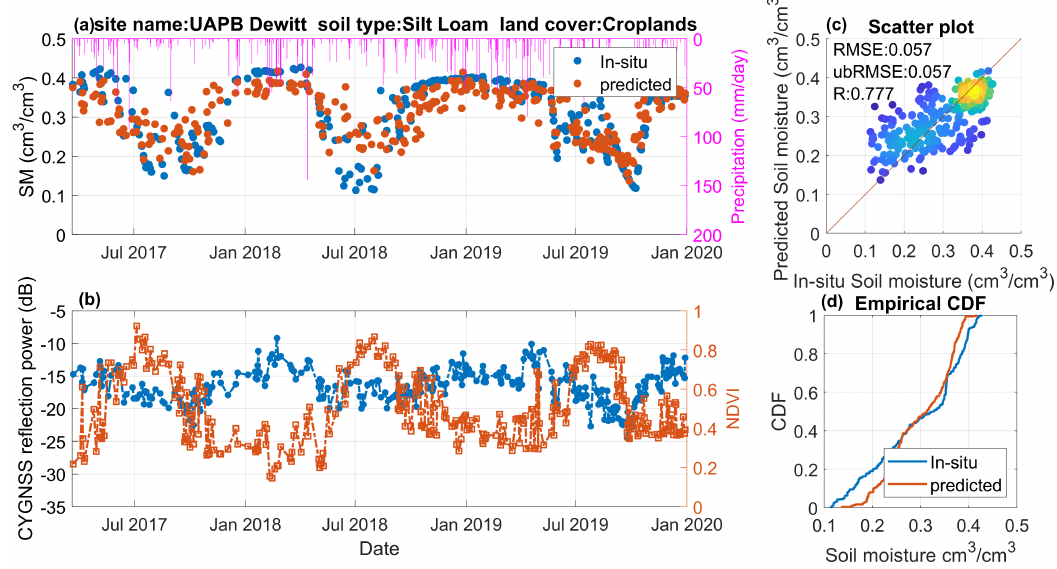
Figure 13. Same as Figure 12 but for site Uapb